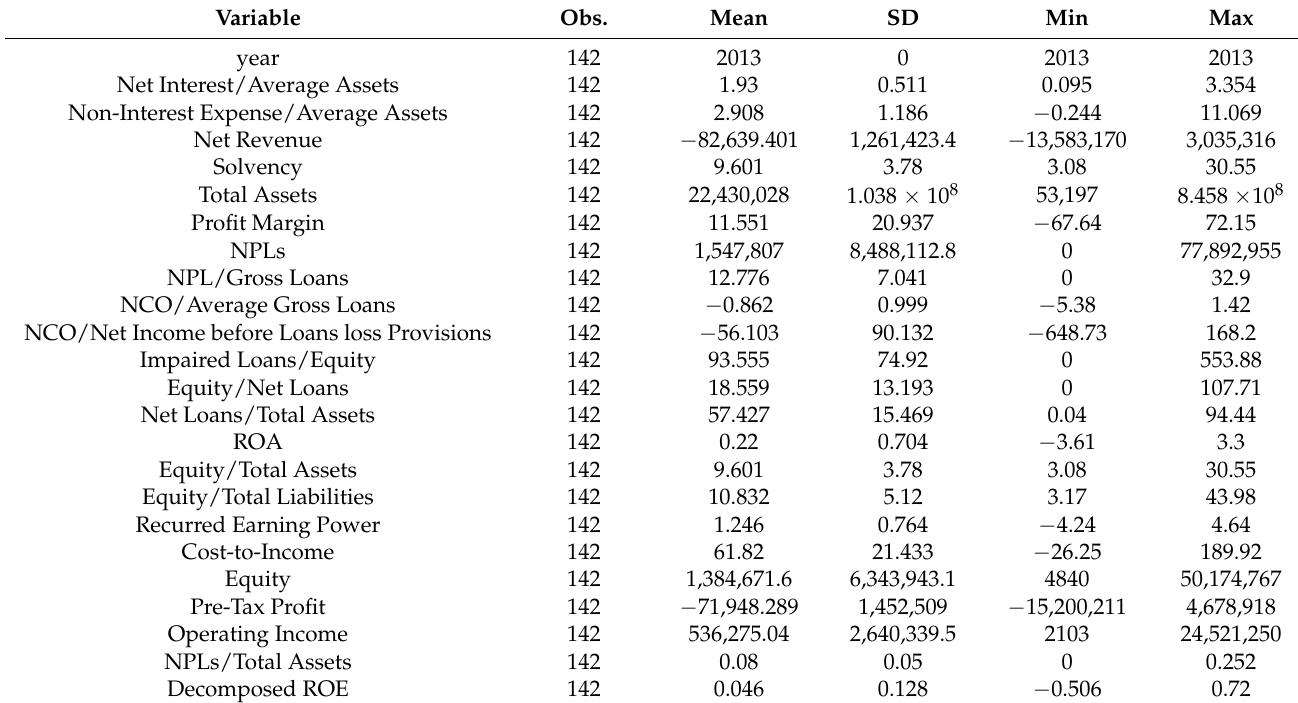
Table A3. Descriptive statistics for the 142 Italian banks for the year 2013.